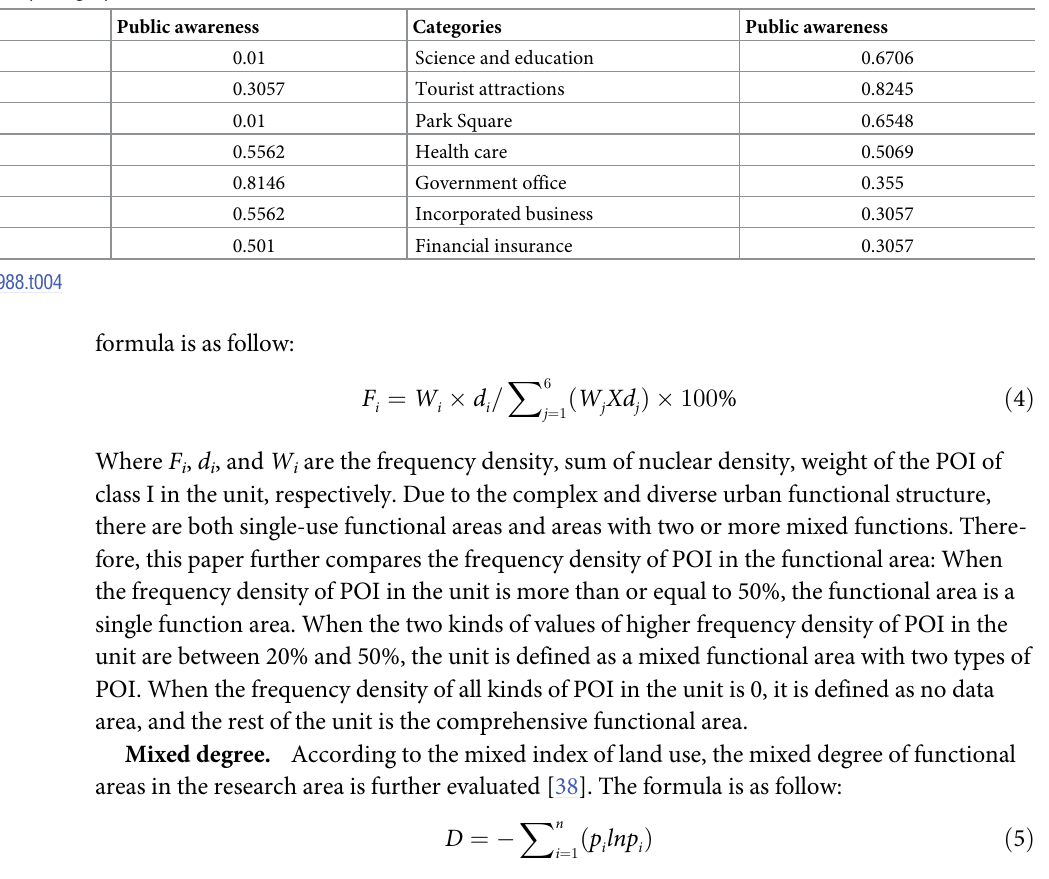
Table 4. Public awareness of POIs of every